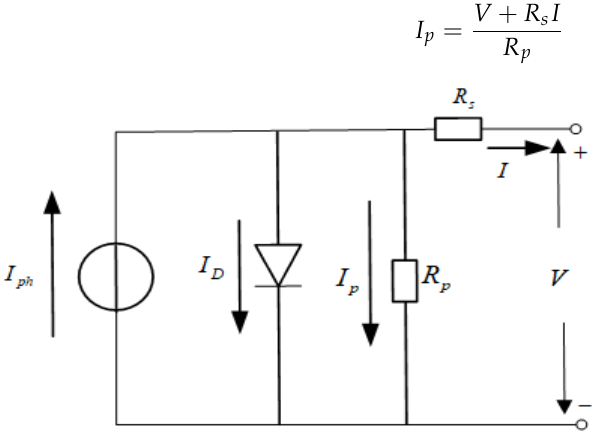
Figure 1. Equivalent circuit of the photovoltaic cell [17–20].